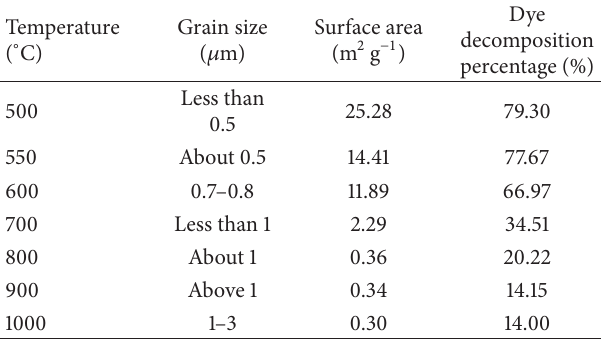
Figure 2: XRD patterns of the BZN powders prepared at 550 ∘ C by the sol-gel and at 1000 ∘ C by the solid-state methods (the bottom pattern is the PDF card number for the cubic BZN). Table 1: Surface area and dye decomposition dependence on the heating temperature of the BZN catalyst (as percentage), after 1h of photocatalytic